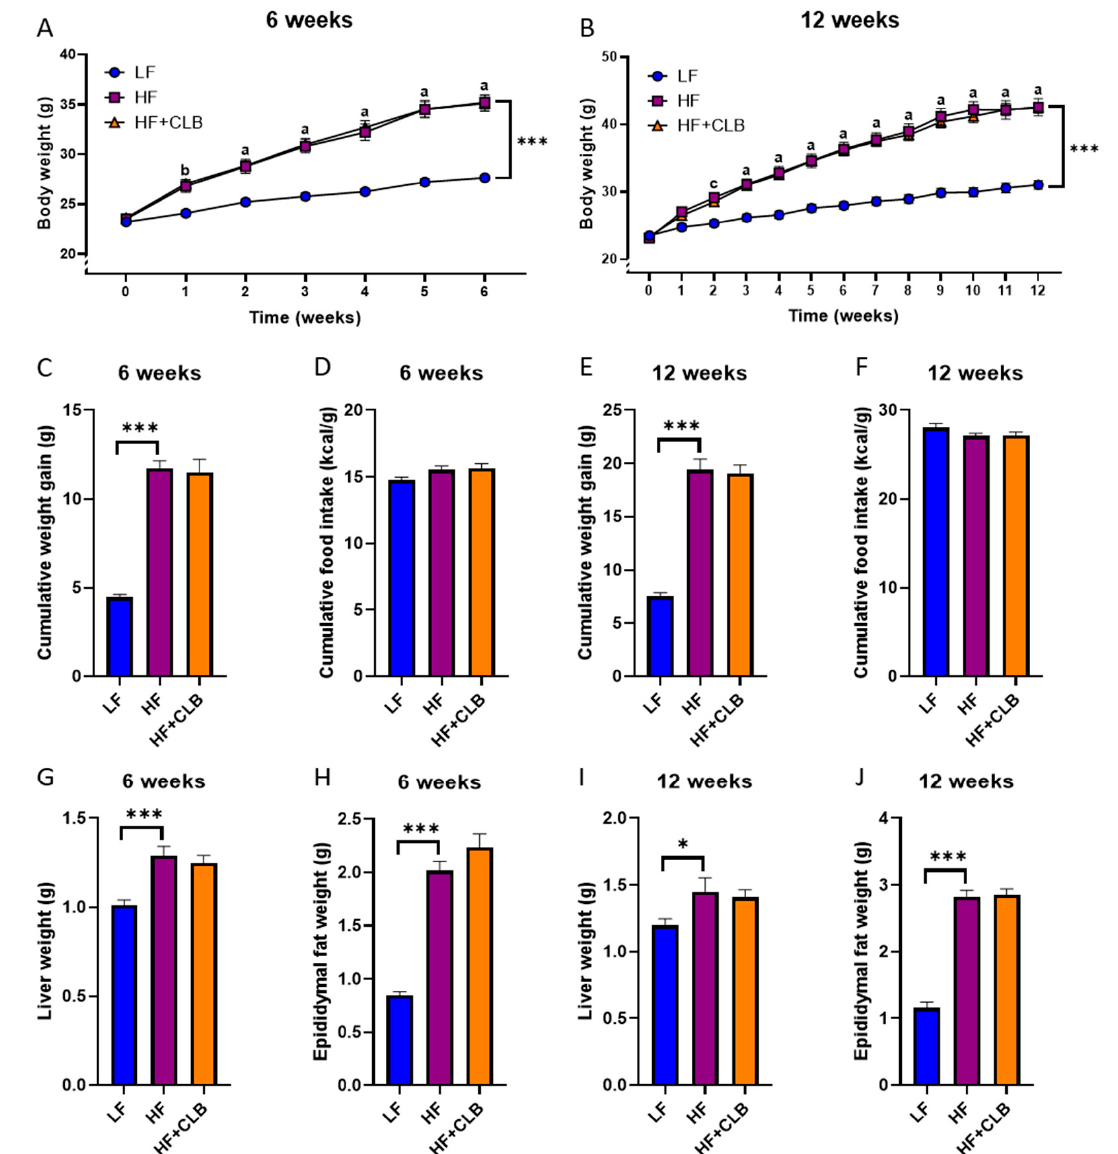
Figure 1. Body, liver, and epididymal fat weight gain and food intake. Mice were divided into six groups to receive either a low-fat diet (10% of energy from fat, LF), high-fat diet (46% of energy from fat, HF), or cloudberry-supplemented high-fat diet (HF+CLB) for six ( A , C , D , G , H ) or twelve ( B , E , F , I , J ) weeks. The weekly weights ( A , B ), the cumulative weight gain ( C , E ), and the weights of livers ( G , I ) and epididymal fat pads ( H , J ) are expressed as grams. The cumulative food intake ( D , F ) is expressed as kcal/g. The data were analyzed with two-way (mixed model) ANOVA for ( A , B ) and one-way ANOVA for ( C – J ), all with the Bonferroni post-test, * p < 0.05 and *** p < 0.001. For ( A , B ), the difference between LF and HF is marked with a ( p < 0.001), b ( p < 0.01), and c ( p < 0.05). The values represent mean ± SEM, n = 12 mice per group except in D and F ( n = 6 per group since two mice in one cage were treated as a single data point).